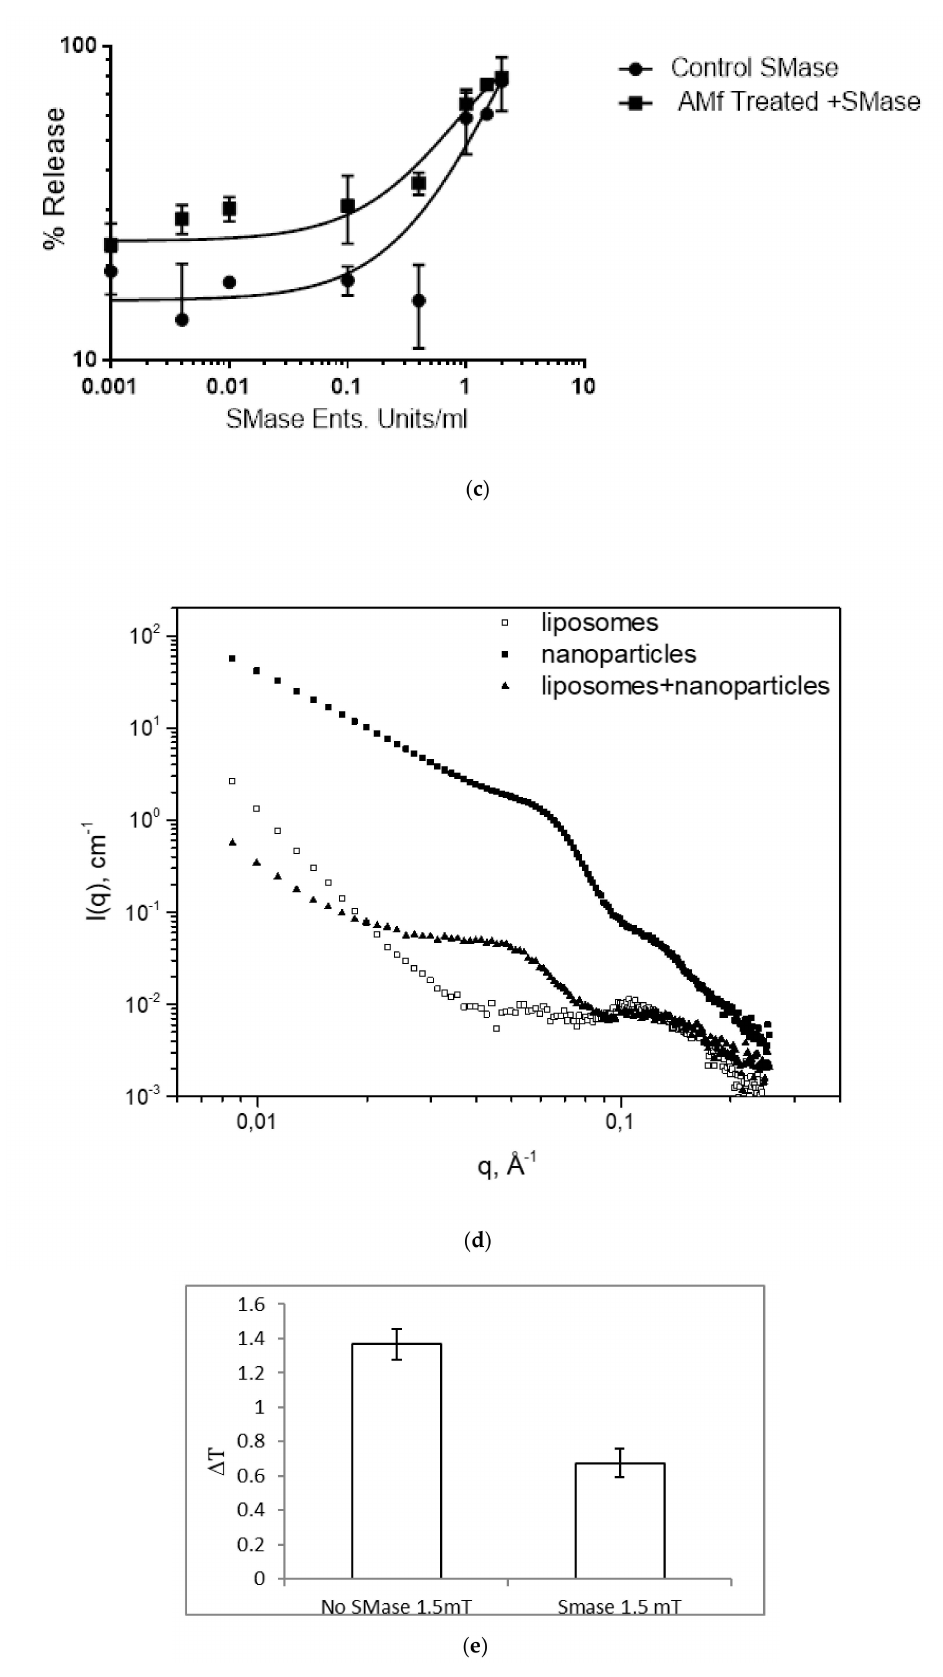
Figure1. MagnetoenzymaticSphingomyelin(SM)liposomes. ( a )SchematicillustrationofSM-liposomes containing Fe 3 O 4 -nanoparticles (dark gray) embedded in the lipid membrane and a payload of